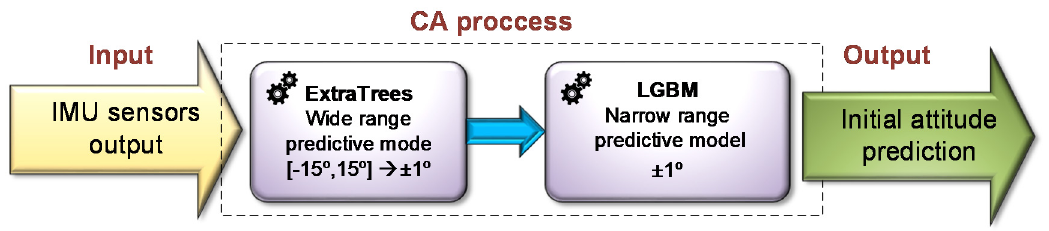
Figure 11. MLCA pyramidal process with the most accurate wide and narrow range regression models.